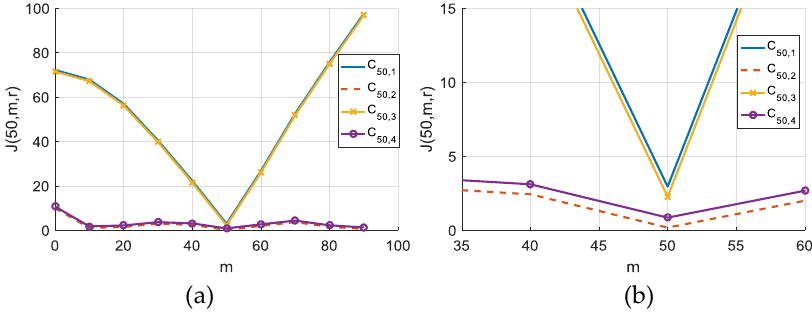
Figure 13. Variation of J ( 50, m , r ) with the respect to the sub-images. ( a ) J ( 50, m , r ) when the rotational velocity is 10 degrees per second and noise level is 5 times range resolution. ( b ) Local enlargement result of J ( 50, m , r ) .